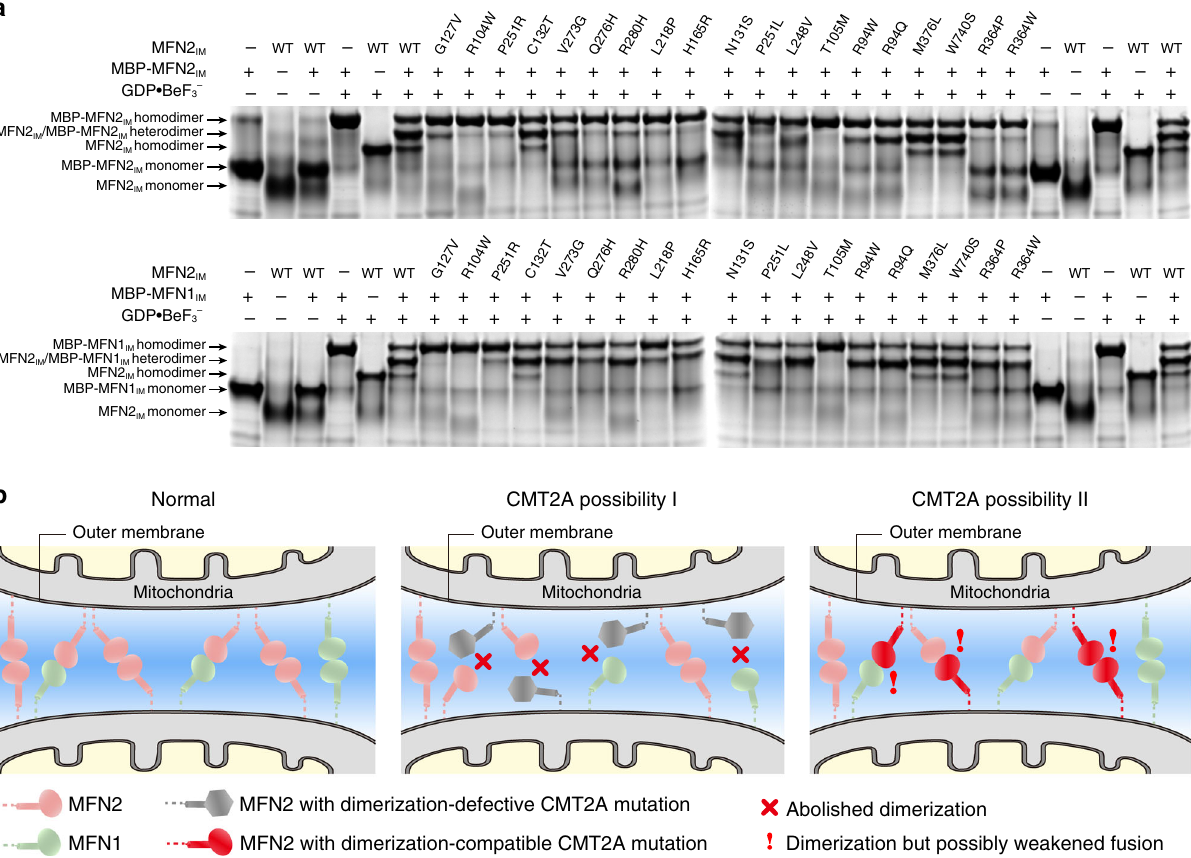
Fig. 7 Interaction between CMT2A-related mutants and wild-type MFN1/2 IM . a G domain-mediated association of CMT2A-related MFN2 IM mutants with MBP-fused MFN2 IM (upper) or MBP-MFN1 IM (lower) tested by native PAGE. b Schematic drawing showing the two causes of CMT2A onset that may be derived from different MFN2 mutations. Source data are provided as a Source Data fi